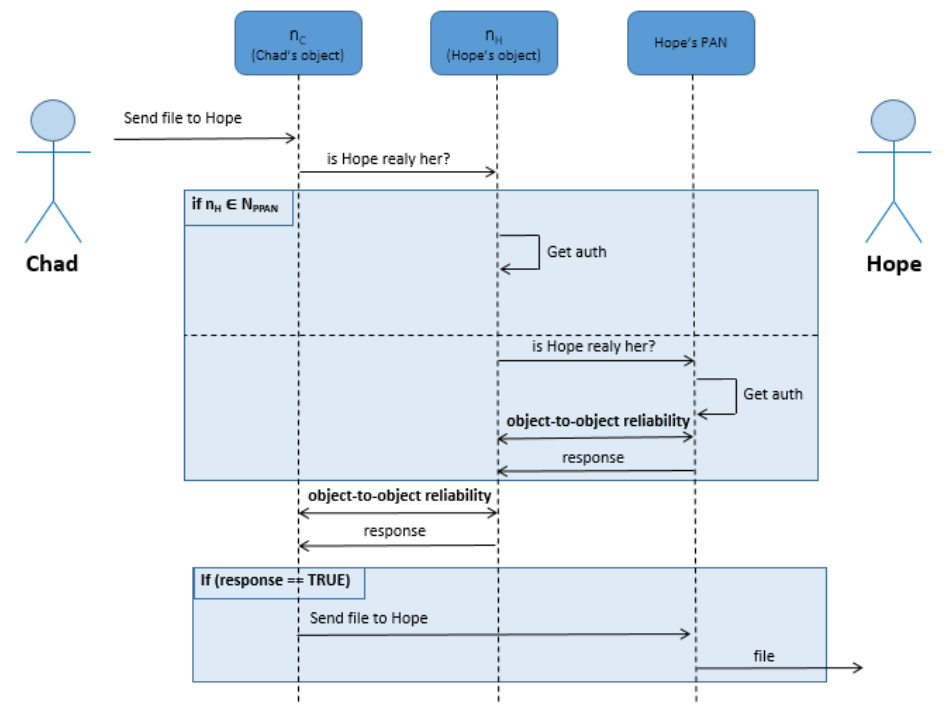
Figure 5. The sequence diagram for a human-to-human